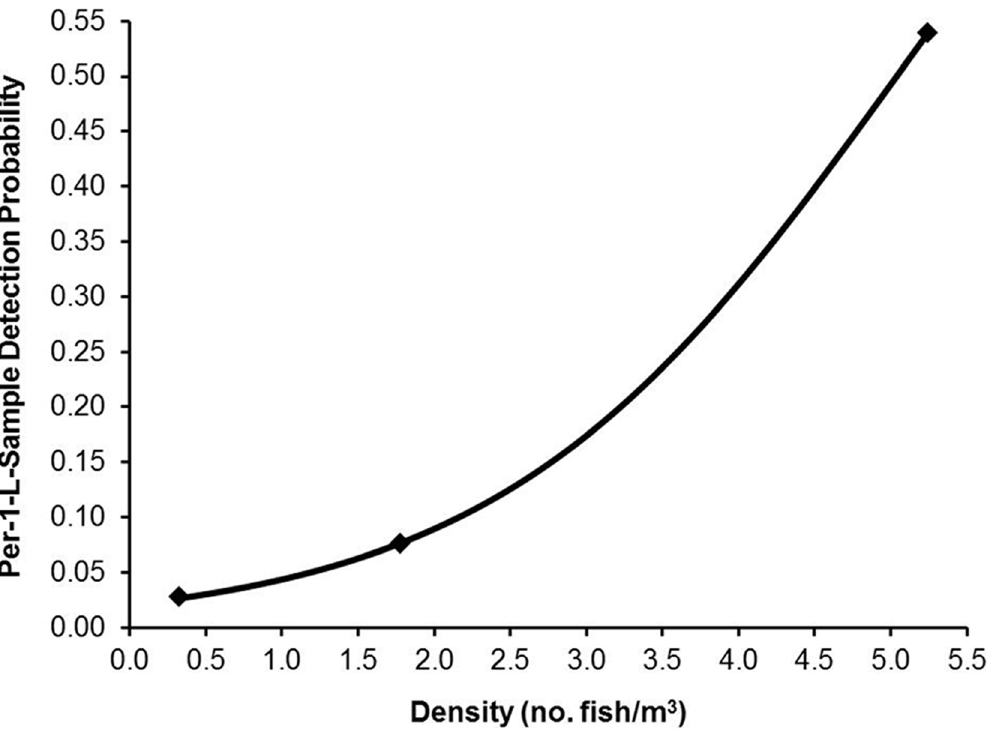
Figure 2. Predicted per-1-L water sample DNA detection probability with increasing densities of African jewelfish in experimental ponds. Detection estimates are based on parameter estimates from the best-approximating hierarchical logistic regression models relating African jewelfish eDNA detection/non-detection data to pond- and sample-level covariates. Filled diamonds represent the low (0.32 fish/m 3 ), moderate (1.75 fish/m 3 ), and high densities (5.24 fish/m 3 ) used in this study.